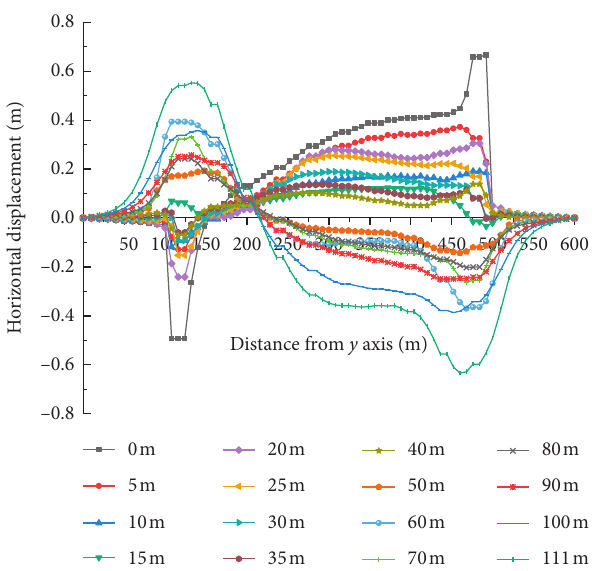
Figure 6: Distribution of horizontal displacement on strike ob- servation